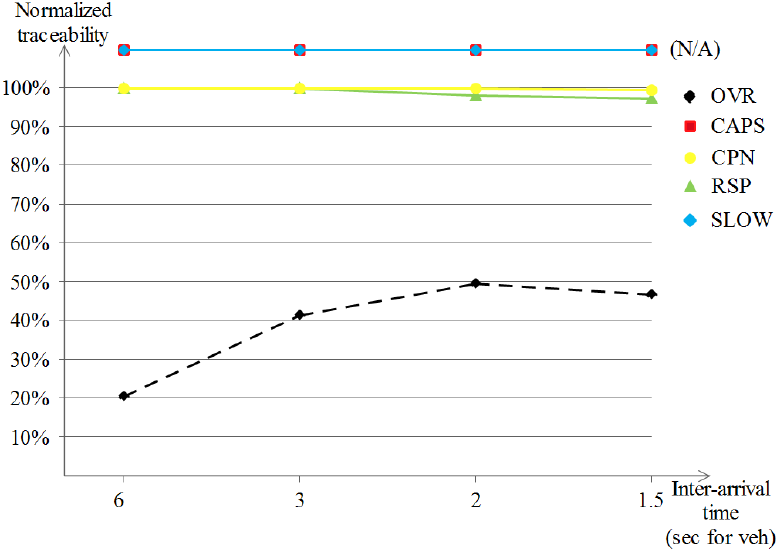
Figure 14. Normalized-traceability of privacy schemes in the highway